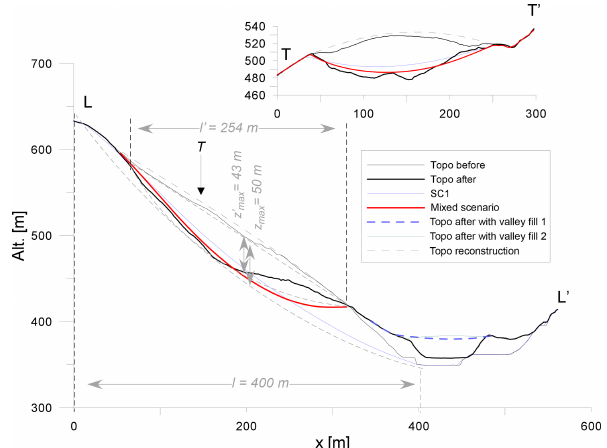
Figure 10. Schematic cross sections of the Shimizu landslide for different scenarios and the manual cross section determined in order to obtain e values (grey lines and text). The two solutions for valley filling are indicated. See Fig. 11 for cross section